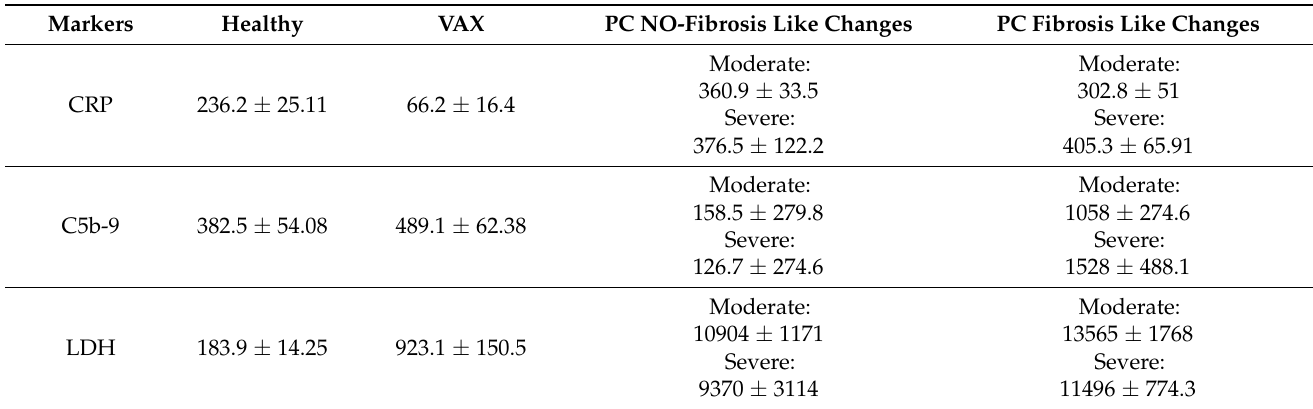
Figure 7. Discrimination among PC patients with or without fibrosis-like symptoms according to plasma levels of IFN- β . ( A ) The contingency graph that describes that lung fibrosis-like changes are more frequent in severe (red bar, 82.6%) than moderate (green bar, 72.4%) COVID-19 patients. Fisher’s exact test was used to determine the possible association between COVID-19 and lung fibrosis events ( p < 0.0001). ( B ) Fraction of total was analyzed according to the levels of IFN- β based on a cut-off (194.3 pg/mL) obtained by receiver operating curve (ROC) analysis; in this latter analysis, the Chi-square test for trend ( p = 0.0154) was applied. Table 2. Analysis of cytokines in the group of post-COVID-19 (PC) patients according to lung fibrosis-like changes. Data are expressed as mean ± SEM